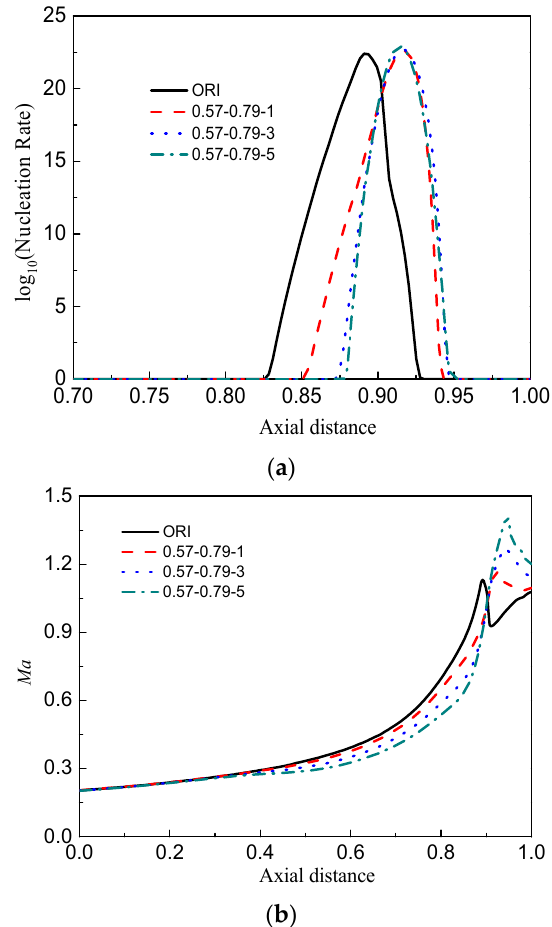
Figure 10. Distribution of steam parameters in the middle of the cascade passage (part 3): ( a ) nucleation rate; ( b ) Mach number.